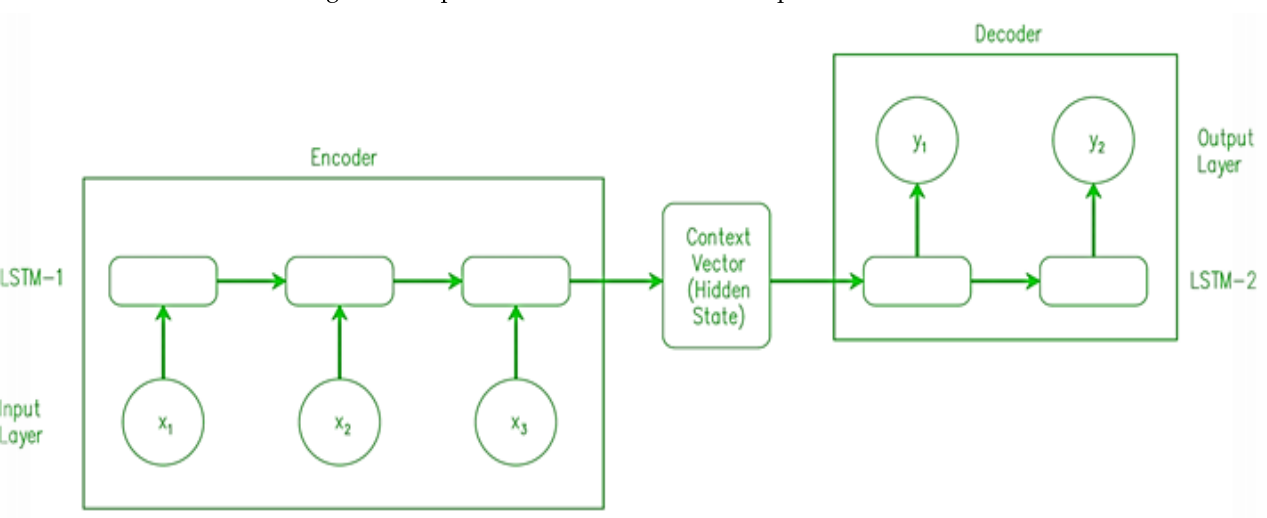
Figure 11. Basic architecture of the Encoder-Decoder LSTM model.4.2.5.